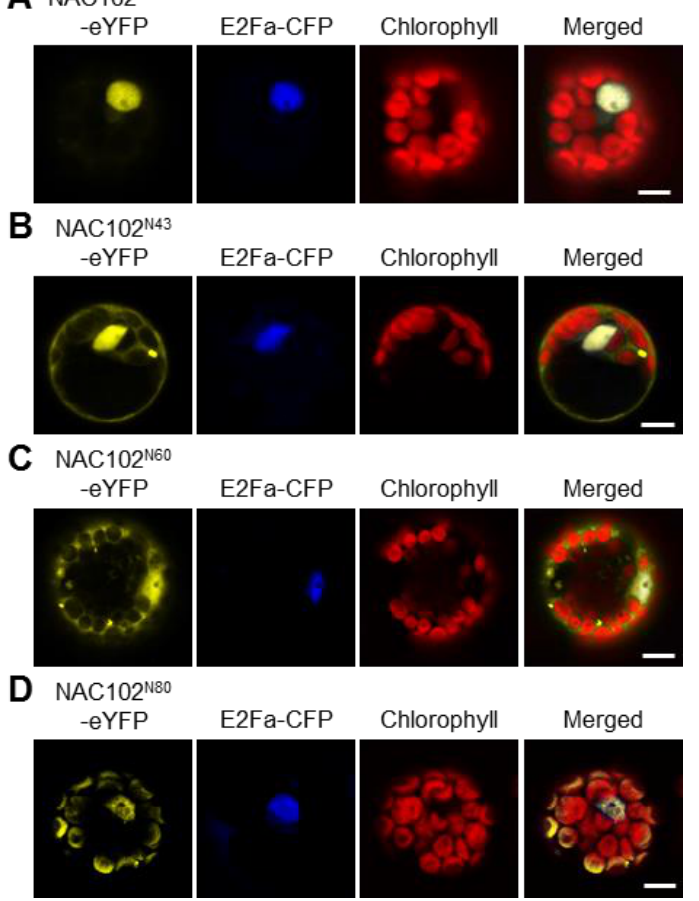
Figure 3. The effects of the N-terminal sequence of NAC102 on its chloroplast localization. The fusion proteins were transiently expressed in Arabidopsis protoplasts. NAC102 Δ N43 -eYFP ( A ) represented the truncated NAC102-eYFP without N-terminal 43 amino acid residues (N43); NAC102 N43 -eYFP ( B ), NAC102 N60 -eYFP ( C ), and NAC102 N80 -eYFP ( D ) represented eYFP fused with N-terminal 43, 60 or 80 amino acid residues, respectively. E2Fa-CFP was used as the nucleus marker and the chlorophyll fluorescence was used as the chloroplast marker. The pictures were captured using confocal microscopy. Bars = 10 µm.